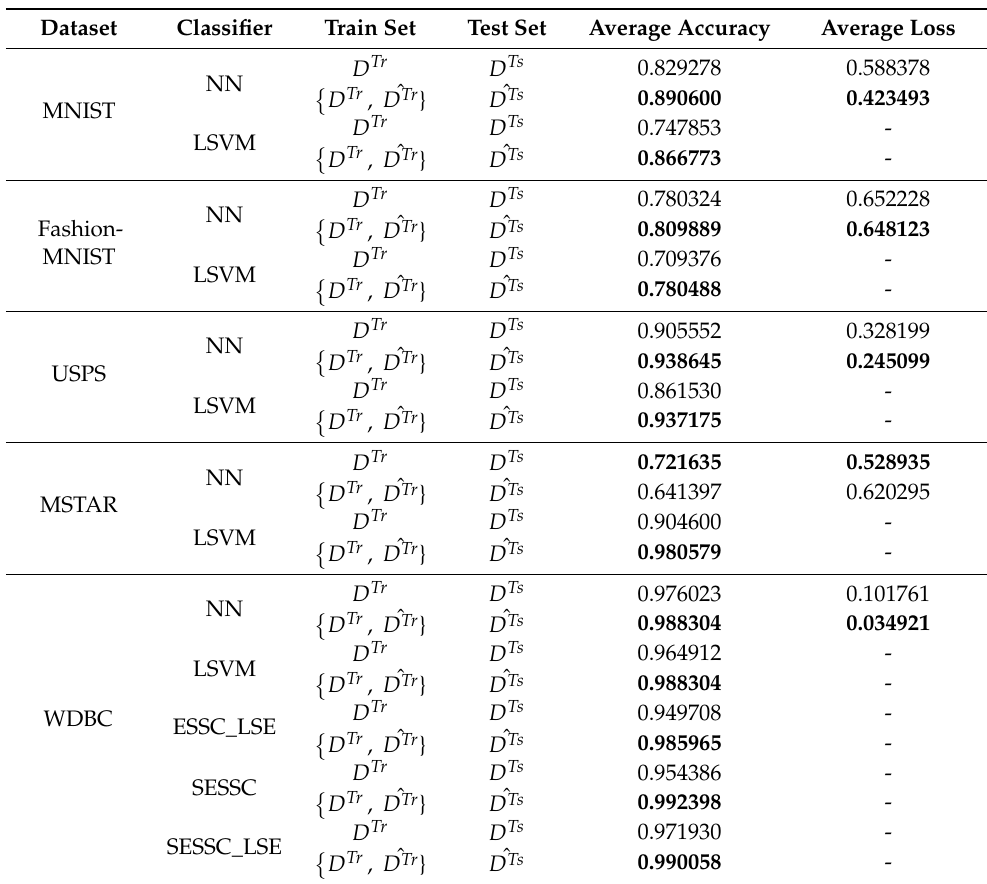
Table 4. Classification results. D Tr is the original training set (without transformation) and { D Tr , ˆ D Tr } is the original training D Tr set augmented with the transformed (using our model) training set ˆ D Tr . Bolded values indicate the best results achieved in each